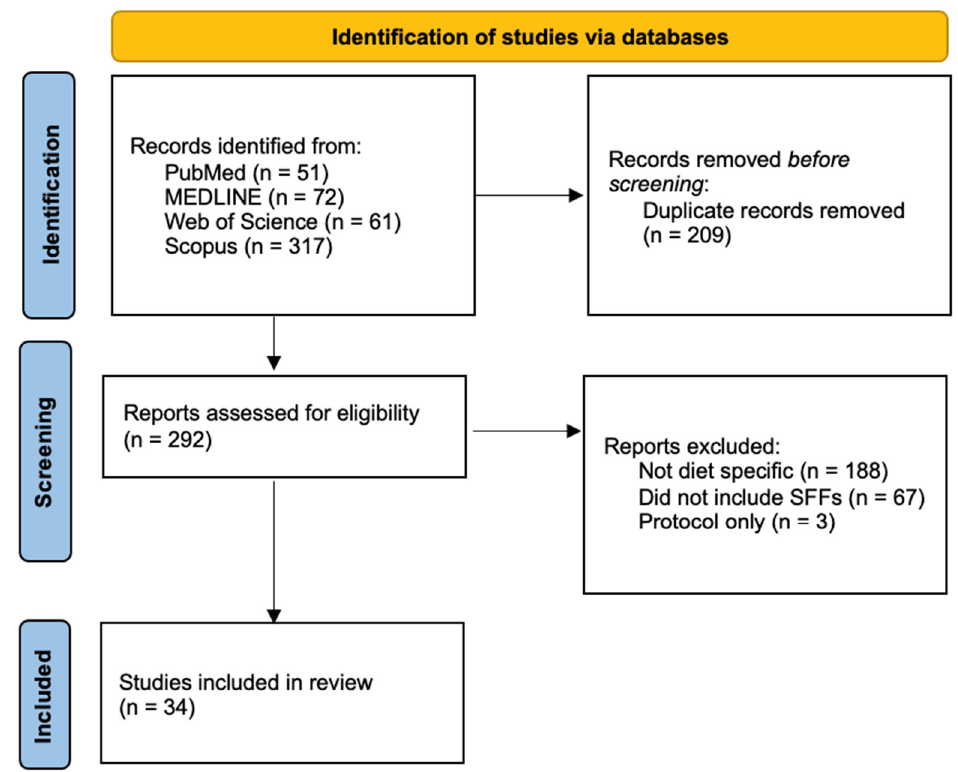
Figure 1. Study Figure 1. Study selection.